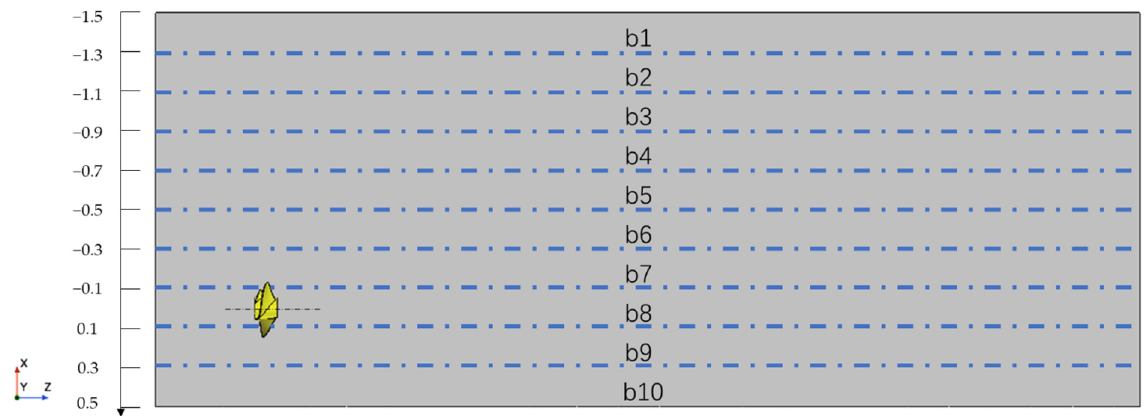
Figure 17. Regions of flow field divided along horizontal direction.